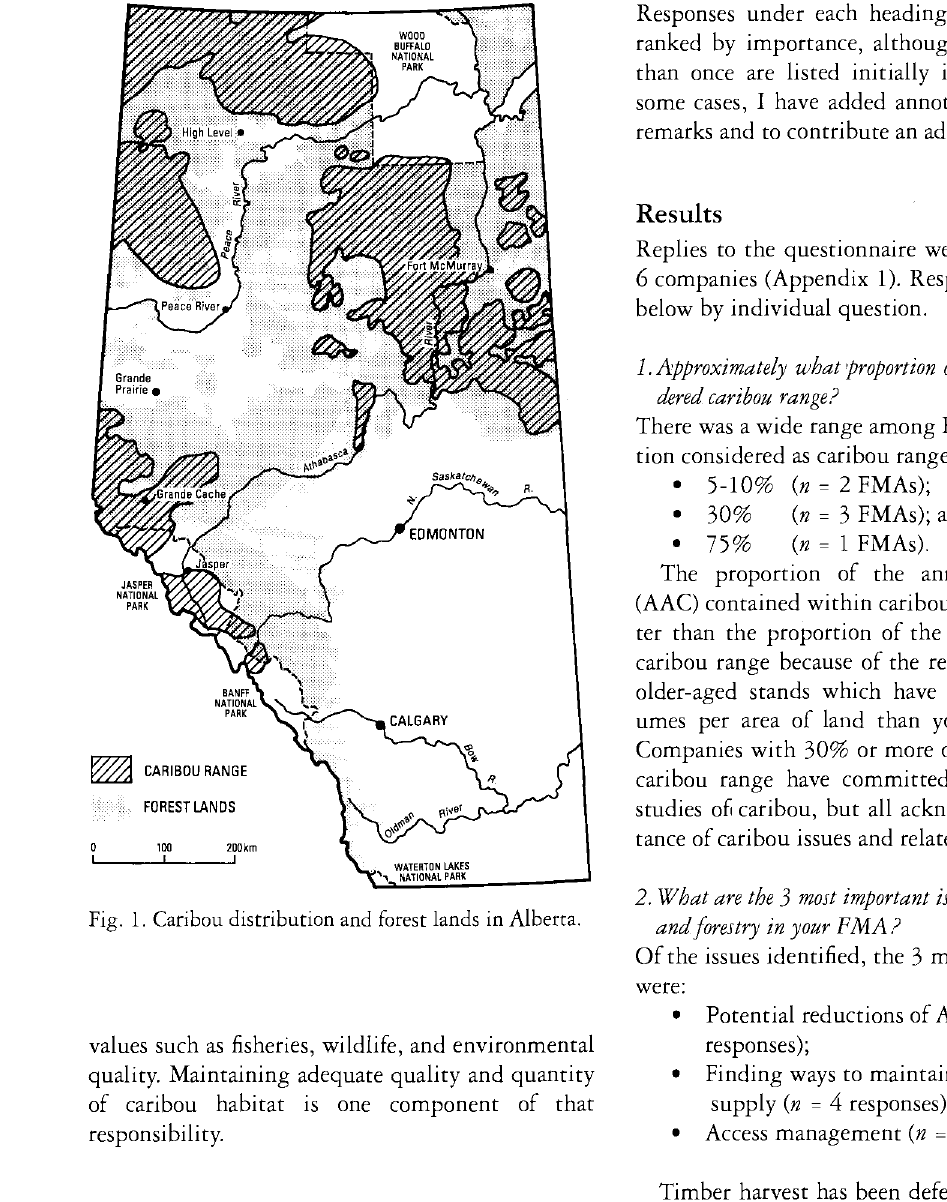
Fig. 1. Caribou distribution and forest lands in